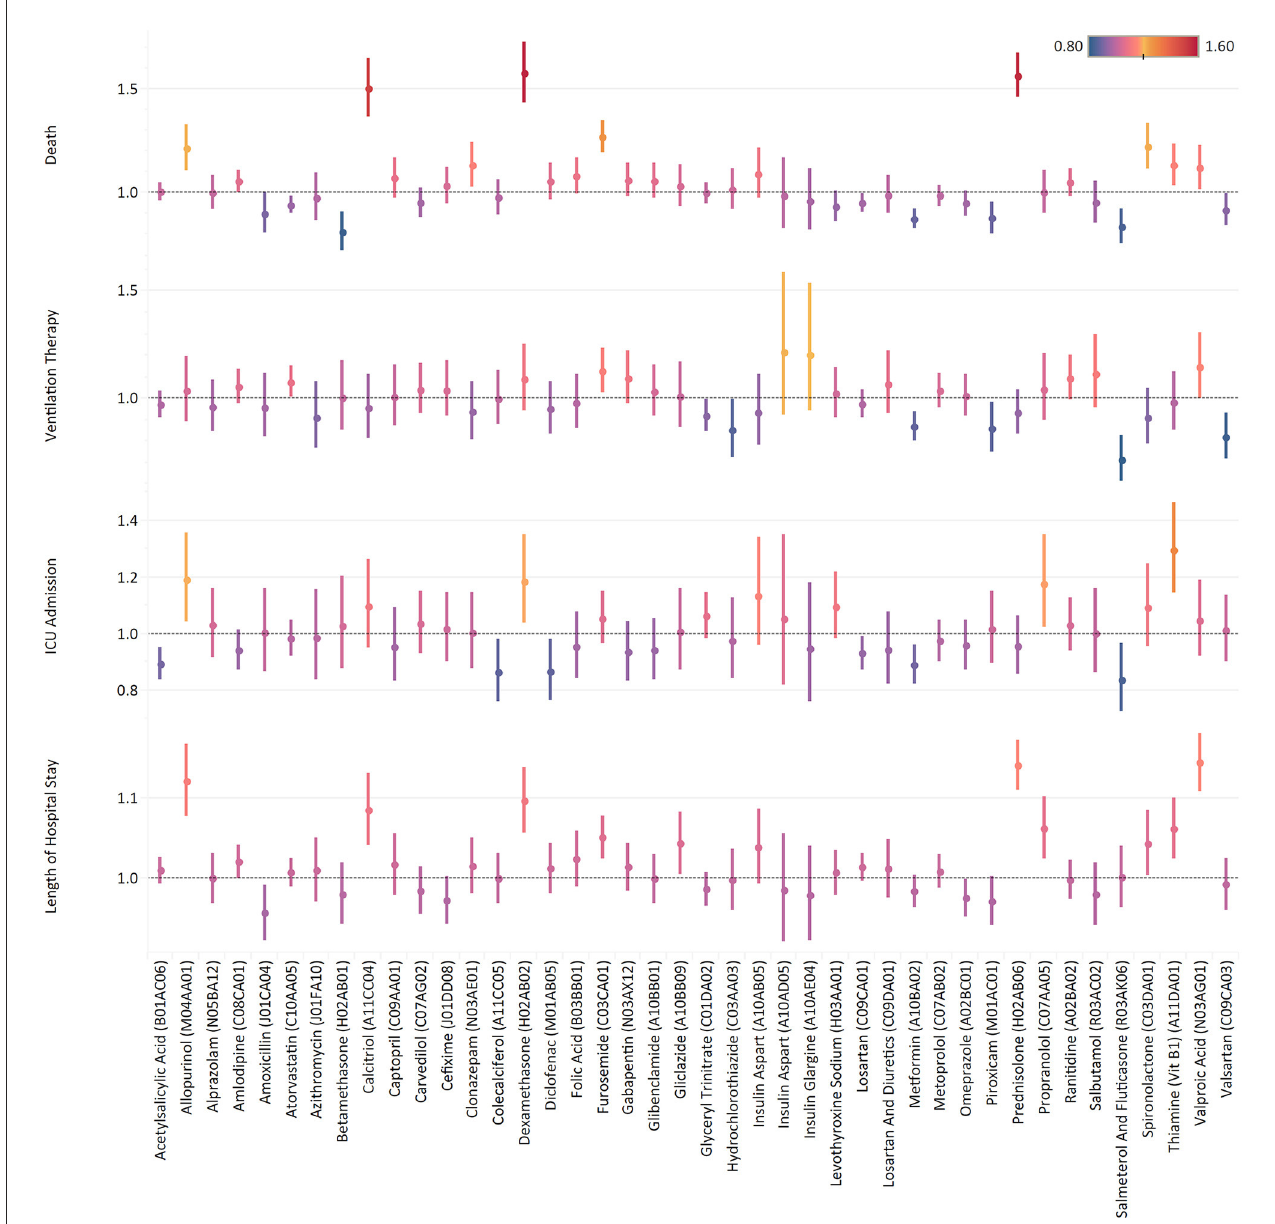
FIGURE4 Change in length of hospital stay along with ORs of ICU admission, ventilation therapy, and death by medications.